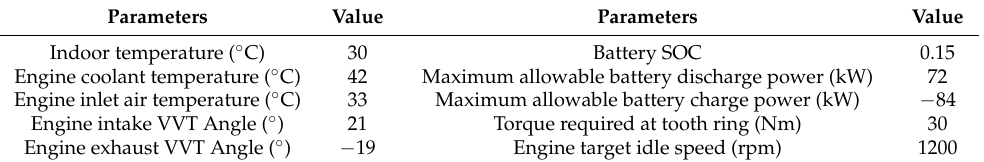
Table 3. Bench test conditions.